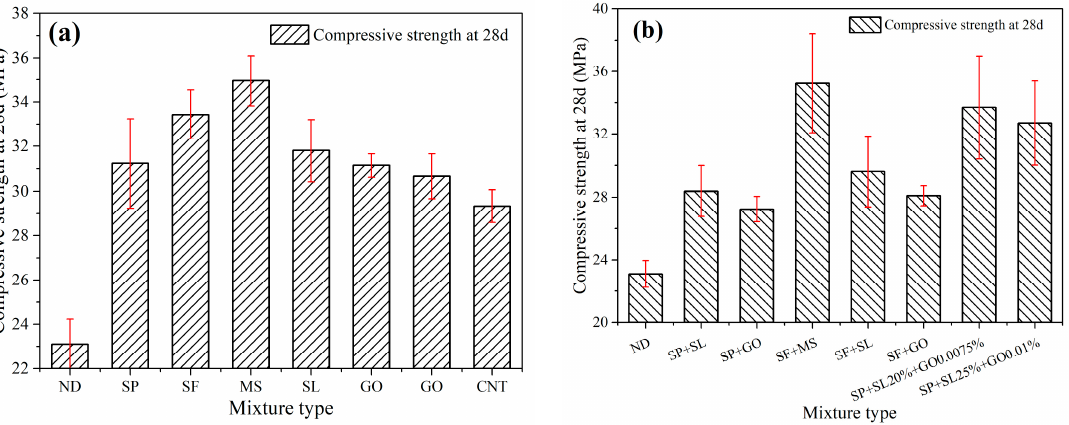
Figure 8. The effect of admixtures added on compressive strength of porous concrete: ( a ) specimen with single admixtures; ( b ) specimen with composite admixtures.